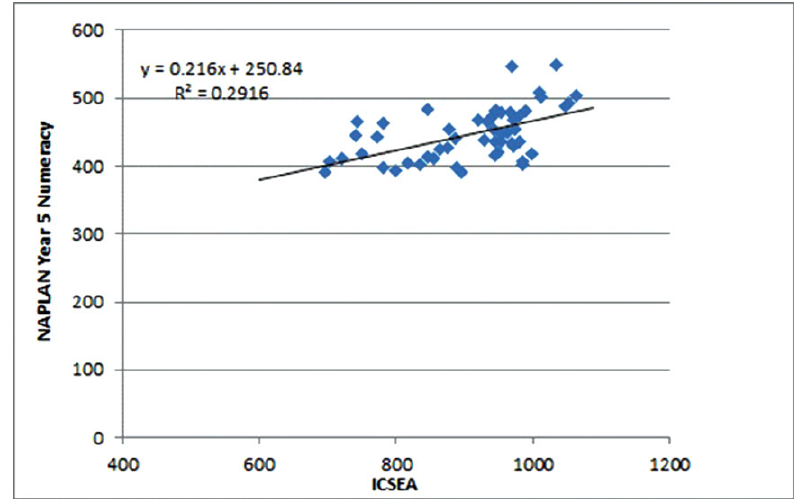
(Colour online) NAPLAN Year 5 Numeracy scores for very remote schools with less than or equal to 80% Aboriginal and Torres Strait Islander students, by ICSEA, 2012 (n = 53).